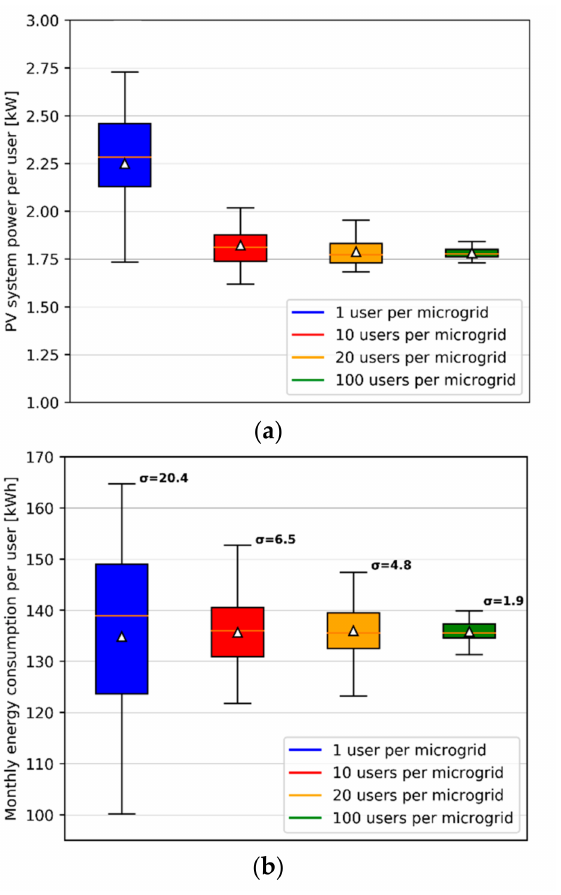
Figure 6. Distribution of the ( a ) PV system capacities and ( b ) monthly energy consumption by household, for